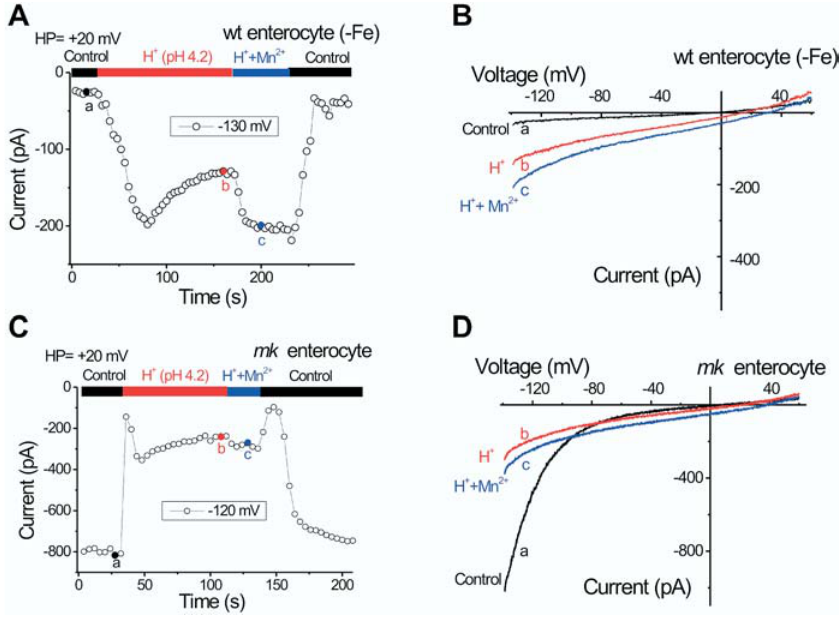
Figure 5. DMT1-Like and G185R-Like Currents in Enterocytes Isolated from Wild-Type and mk / mk Mice,